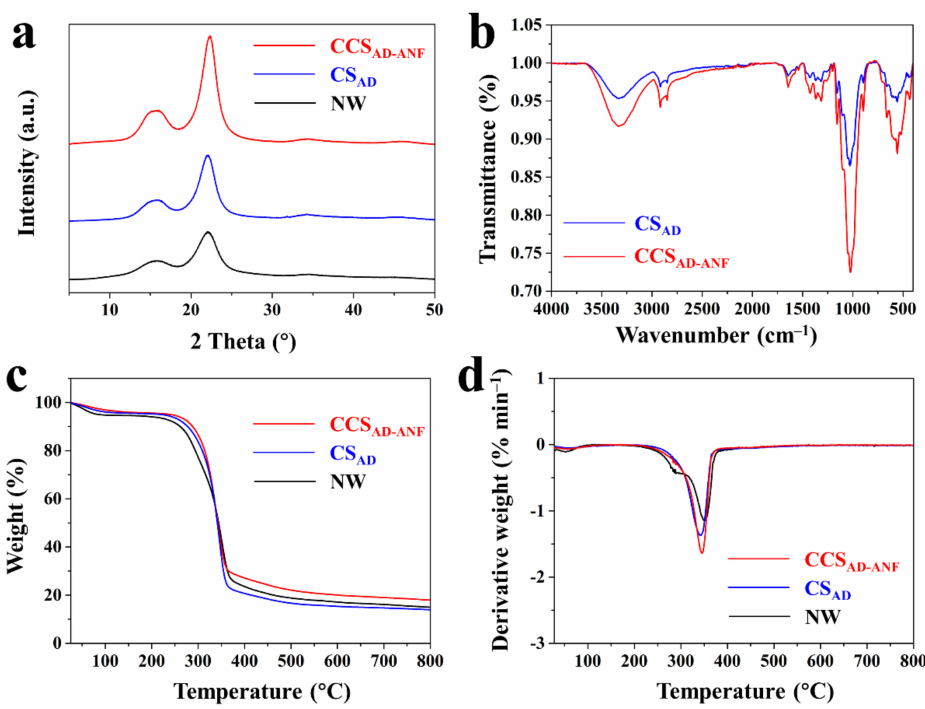
Figure 5. ( a ) XRD patterns of NW, CS AD and CCS AD-ANF . ( b ) FTIR curves of CS AD and CCS AD-ANF . TGA ( c ) and DTG ( d ) curves of NW, CS AD and CCS AD-ANF